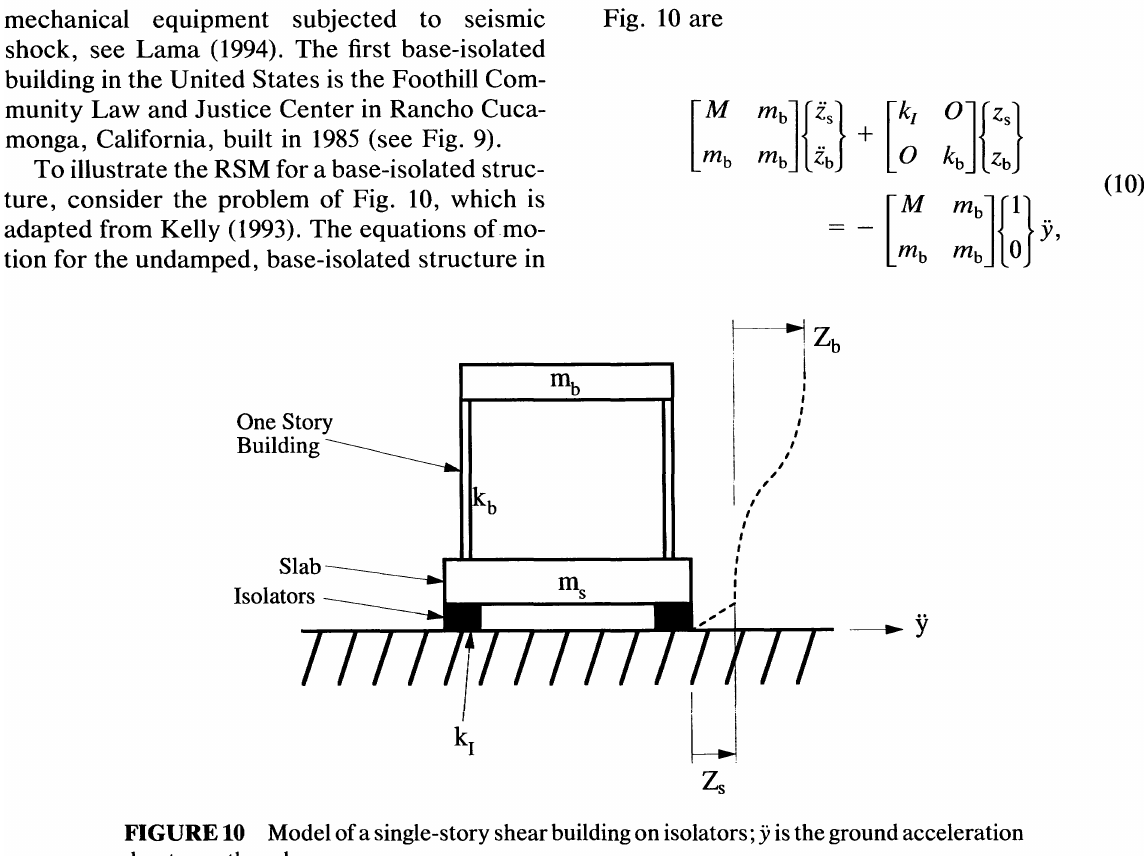
FIGURE 9 Cross section of the Foothill Communities Law and Justice Center showing isolators in the subbasement. Used by permission from Kelly (1993).